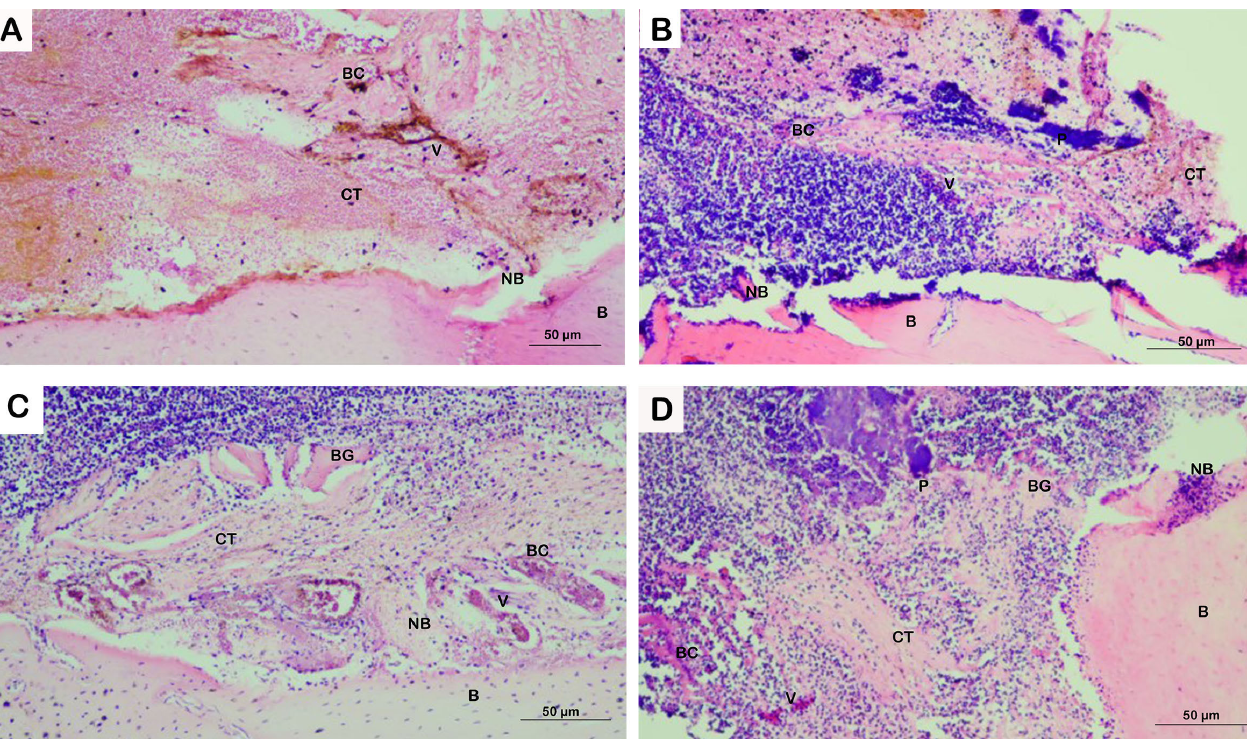
FIGURE 6 - Hematoxylin-eosin staining with 100x magnification on day 30 of all groups. A. Control / PEG Group, B. Propolis extract + PEG group, C. BBG + PEG group, D. Propolis extract + BBG + PEG group. B: bone, NB: new bone, CT: connective tissue, V: vessels, BG: bovine bone graft, BC: blood clot, P: propolis